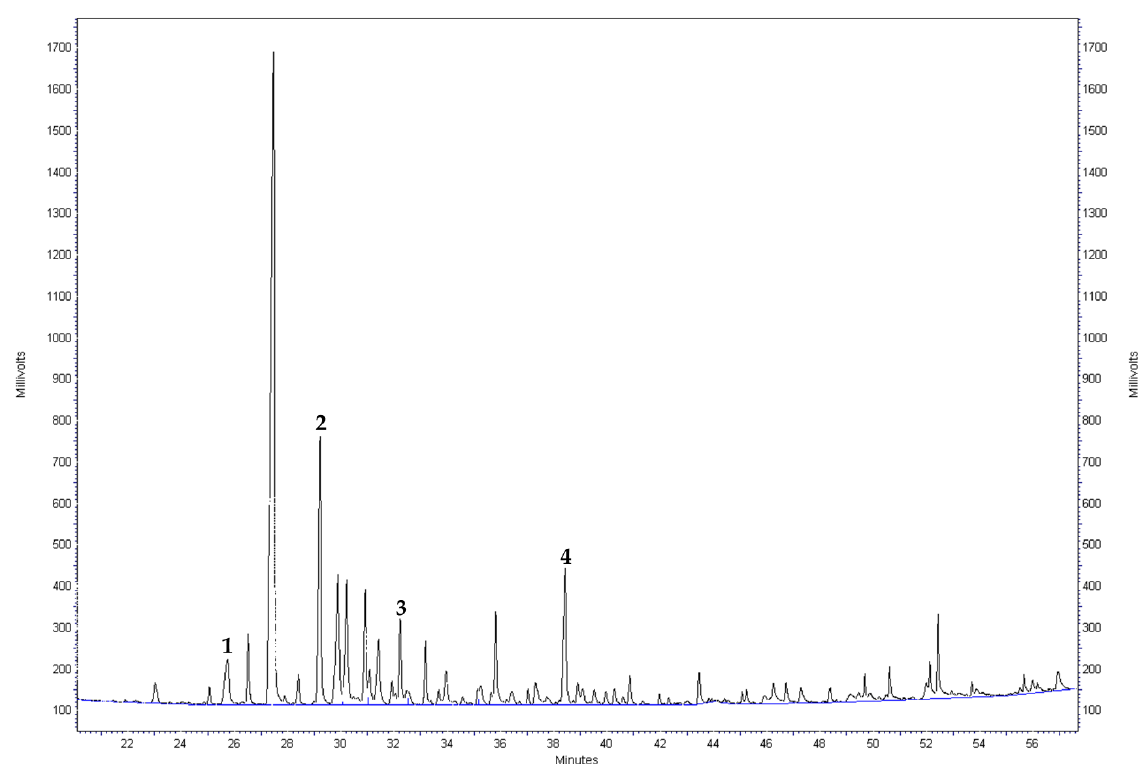
Figure A2. Chromatogram of sample of ripe Habanero pepper harvest from black soil and Jaguar variety: (1) 1-hexanol, (2) hexyl-3-methyl butanoate, (3) 3,3-dimethyl-1-hexanol, and (4) cis-3- hexenyl hexanoate.